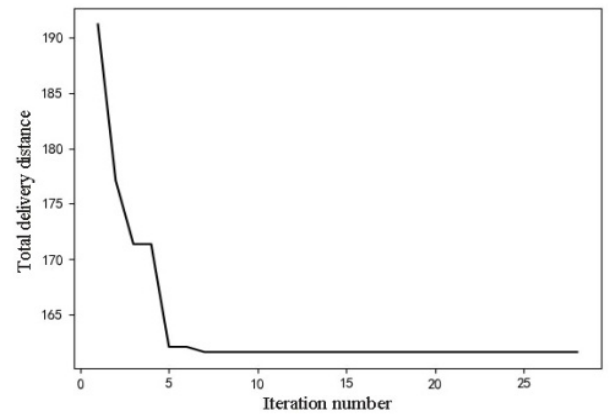
Figure 9. The iteration curve of the depot A.